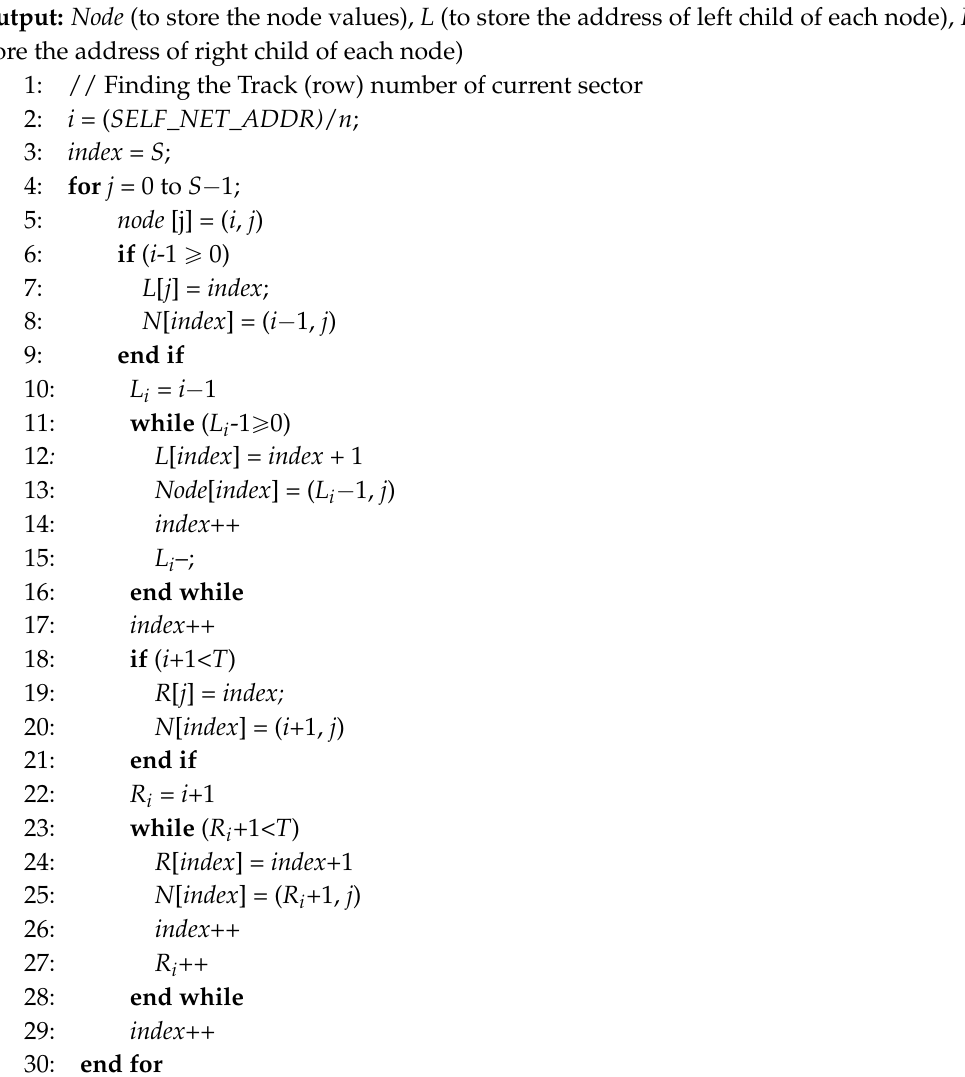
Algorithm 3. Build_Tree(), implemented at each